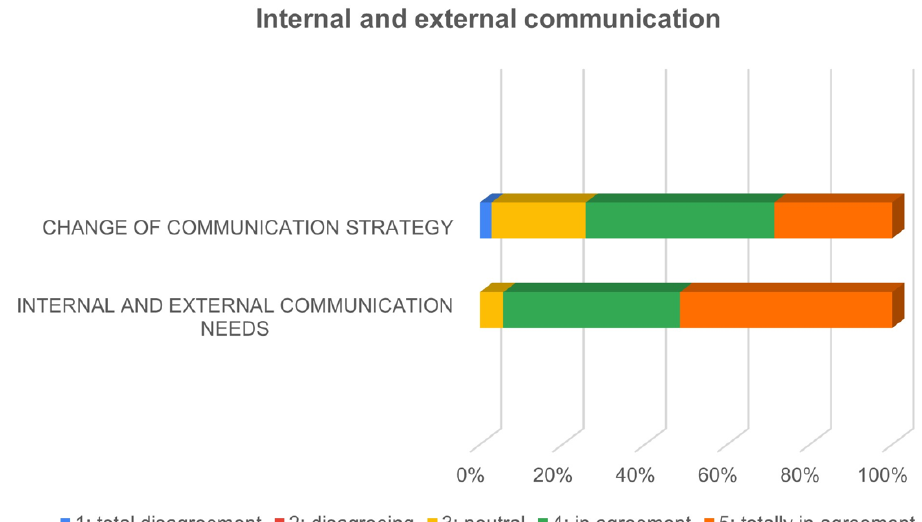
Figure 6. Internal and external communication.